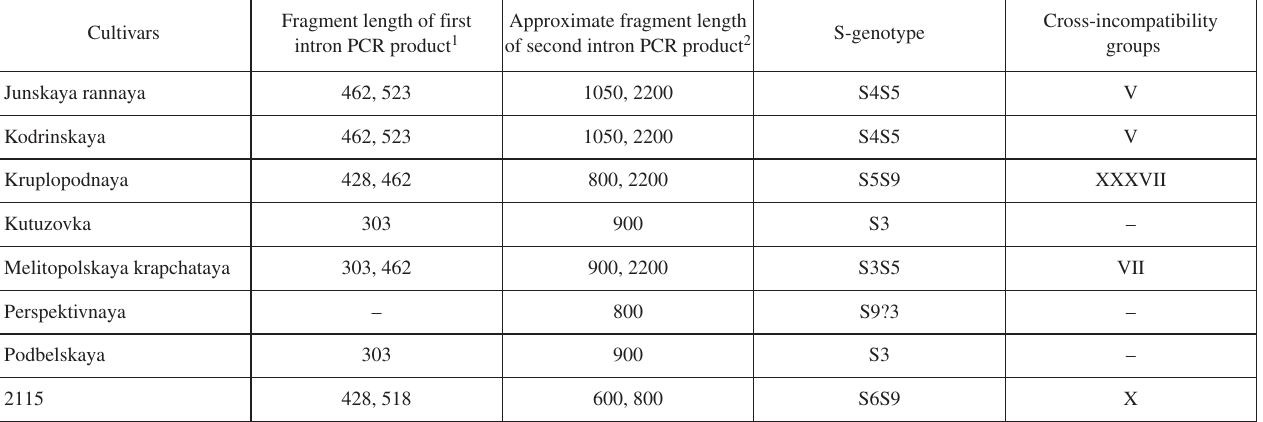
Table 1: Fragment lengths of first and second intron regions, S-genotype and respective cross-incompatibility groups of Ukrainian sweet cherry cultivars